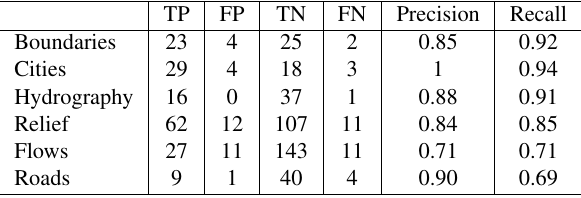
Table 3: Results of multi-labeling on our evaluation dataset.